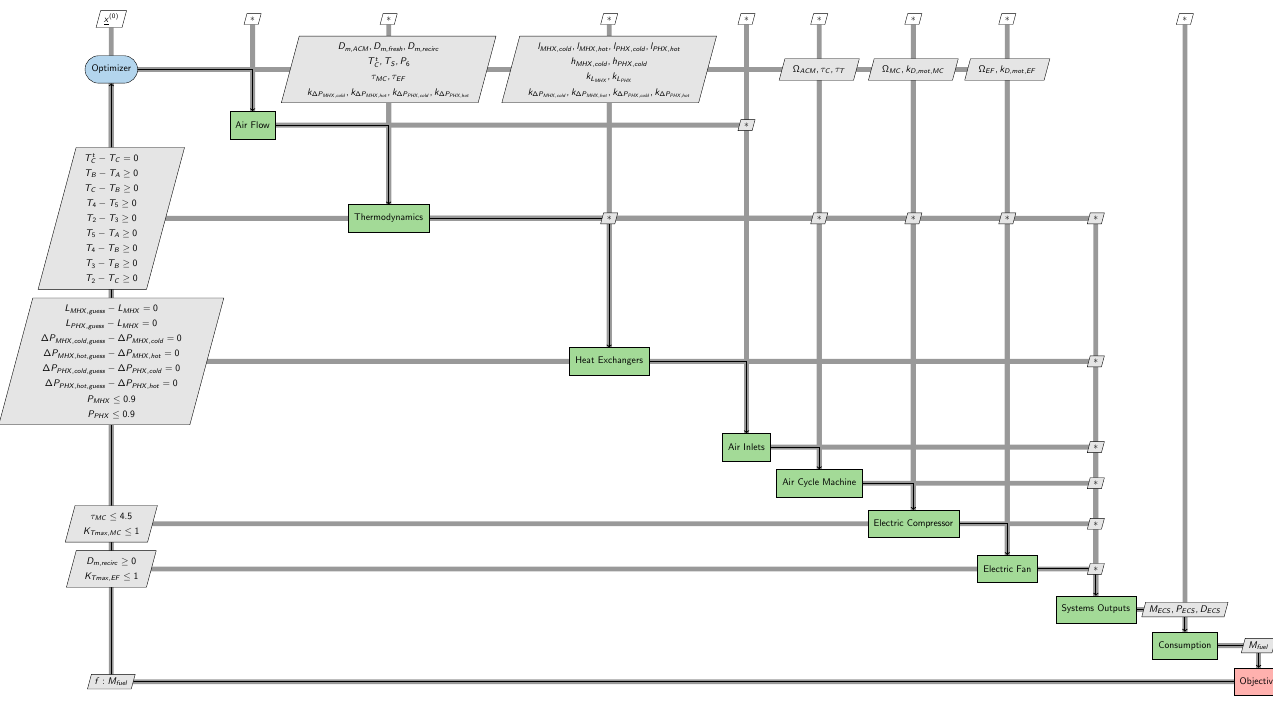
Figure 13. XDSM diagram for the electric ECS sizing.